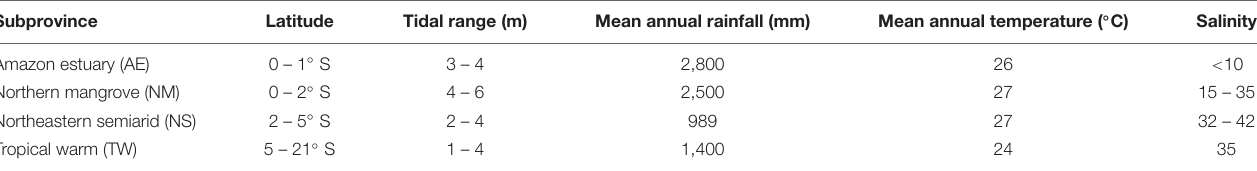
TABLE 1 | Summary of environmental characteristics found in the four subprovinces of the Brazilian coast. Subprovince Latitude Tidal range